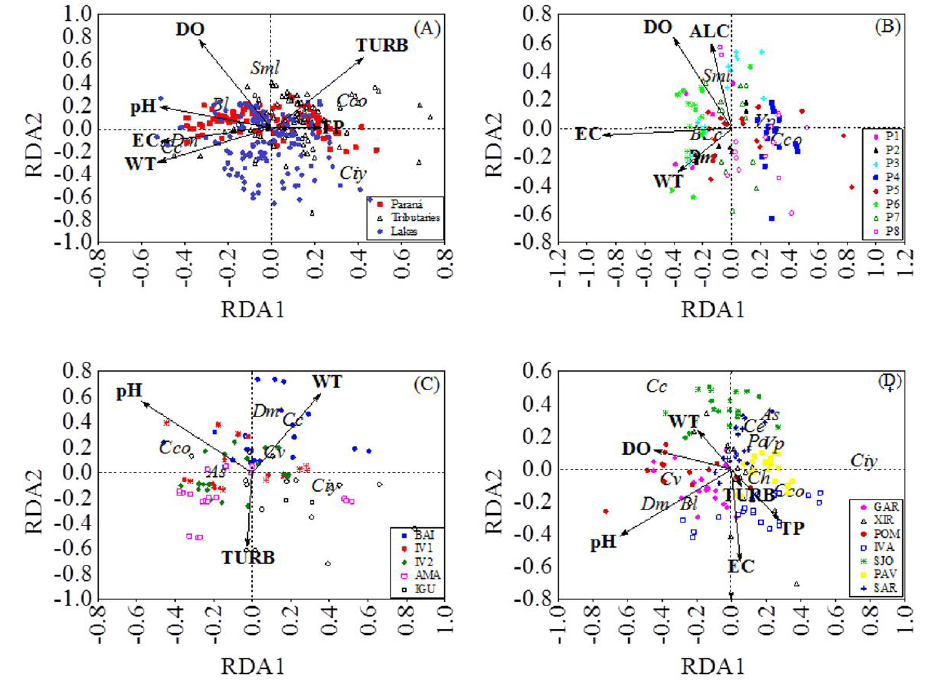
Figure 6. Biplot of the redundancy analysis (RDA) showing the association between ostracod community structure and limnological variables in (A) all environments, (B) Paraná River, (C) tributaries and (D) lakes. WT = water temperature, EC = electrical conductivity, DO = dissolved oxygen, TURB = turbidity, TP = total phosphorus. Dm = Diaphanocypris meridana , Cc = Cypricercus centrura , Bl = Bradleytriebella lineata , Sml = Stenocypris malayica , Cco = Cypretta costata , Cv = Cypridopsis vidua , Ciy = Cytheridella ilosvayi , Vp = Vestalenula pagliolii , As = Alicenula serricaudata , Pa = Pseudocandona agostinhoi , Ce = Candobrasilopsis elongata , Ch = Cabelodopsis hispida